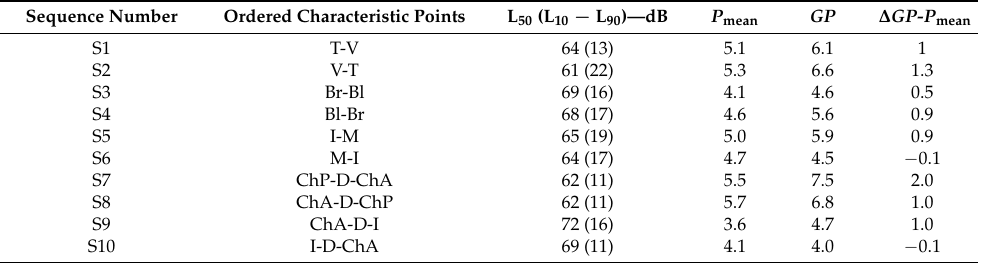
Table 4 Pleasantness averaged both over participants and over time ( P mean ), the global sound pleasantness ( GP ) averaged over participants, and the difference between both ( Δ GP ‐ P mean ), for each of the 16 sequences.